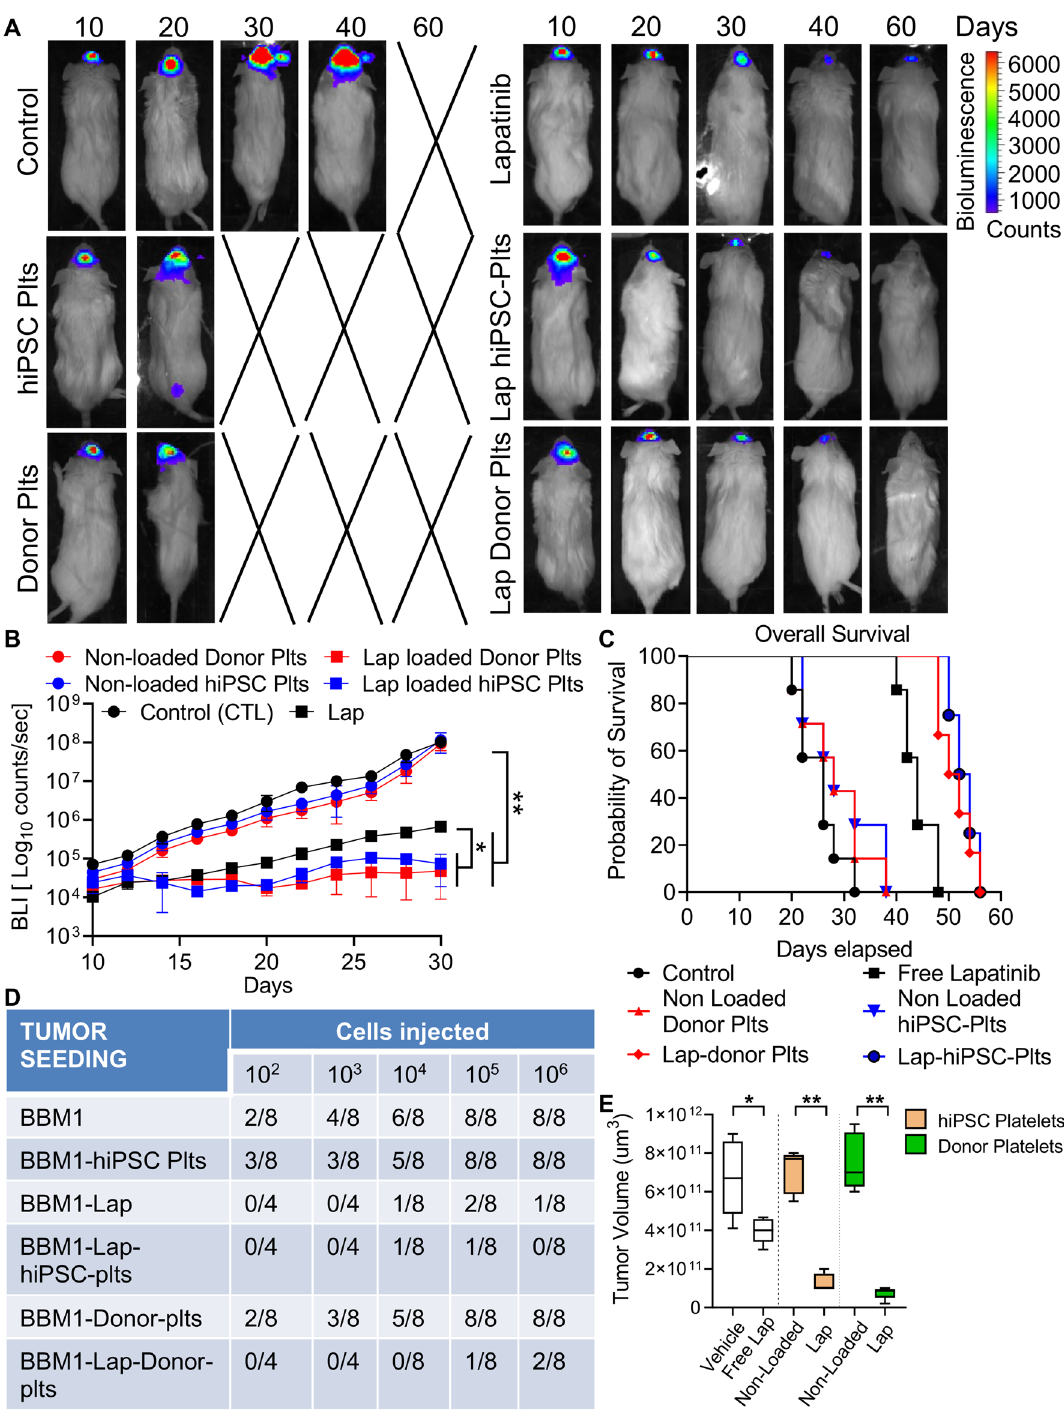
Figure 4. Therapeutic efficacy of lapatinib-loaded hiPSC-platelets in vivo. (A) Representative BLI images of xenografted BBM1-derived tumor-bearing female NOD/SCID mice treated with vehicle (control), free lapatinib, and non-loaded and lapatinib-loaded hiPSC- and donor-derived platelets every 3 days. (B) Bioluminescence was quantified for BBM1- derived tumor-bearing female NOD/SCID mice throughout the experiment, as indicated. Mice were injected with vehicle (control), free lapatinib, and non-loaded and lapatinib-loaded hiPSC- and donor-derived platelets every 3 days. * indicates p < 0.05, ** indicates p < 0.001. Each group contains n = 7 mice. (C) Overall survival of variously treated BBM1- derived tumor-bearing female NOD/SCID mice. Control vs. non-loaded hiPSC- and donor-derived platelets, ns (non- significant); control vs. lapatinib, p < 0.05; control vs. lapatinib-loaded hiPSC- and donor-derived platelets, p < 0.001. (D) Tumor-seeding capability of BBM1 cells in female NOD/SCID mice pre-treated with vehicle (control), and non-loaded and lapatinib-loaded hiPSC and donor-derived platelets. (E) Tumor volume of BBM-derived tumor-bearing NOD/ SCID mice treated with vehicle, free lapatinib, and non-loaded and lapatinib-loaded hiPSC- and donor-derived platelets, measured at 40 days post-implant (n = 7 per group). Control vs. lapatinib, p < 0.05; control vs. free lapatinib, * p < 0.05; non-loaded platelets vs. lapatinib-loaded platelets, ** p <